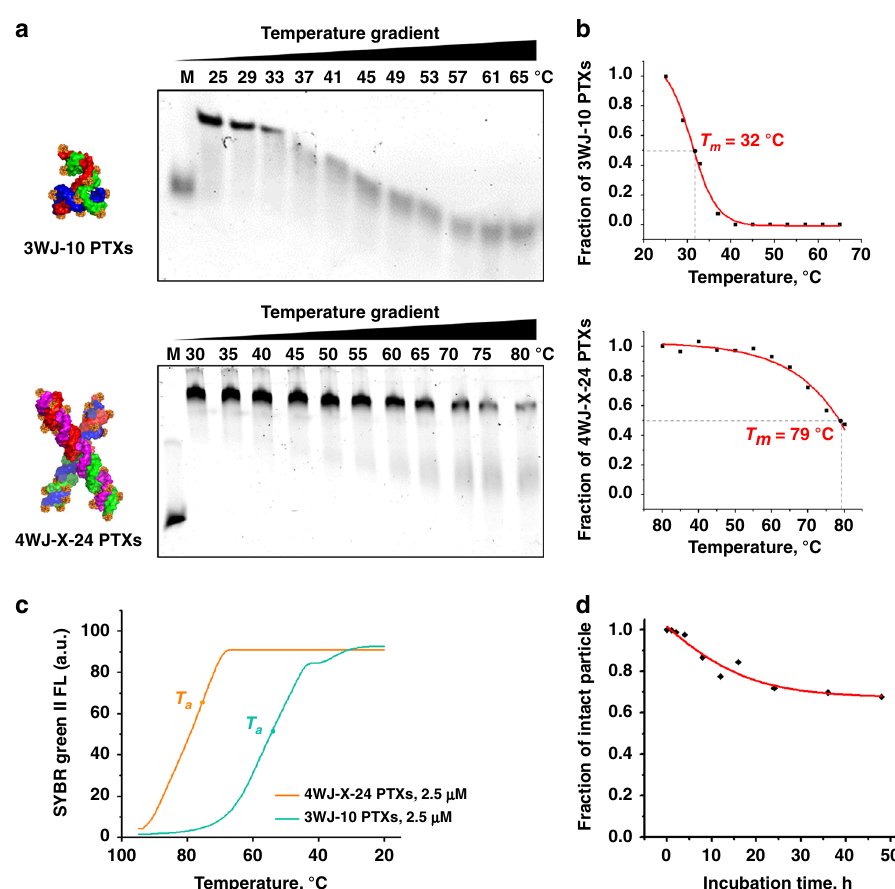
Fig. 4 Thermodynamic and chemical stability of 4WJ-X-24 PTXs nanoparticles. a Representative TGGE showing the T m of 3WJ-10 PTXs (M = 20 nucleotides monomer) and 4WJ-X-24 PTXs (M = 40 nucleotides monomer) nanoparticles. b Quantitative calculation of T m from the representative TGGE for 3WJ-10 PTXs and 4WJ-X-24 PTXs nanoparticles. c T a comparison of 4WJ-X-24 PTXs (orange) and 3WJ-10 PTXs (green) nanoparticles in a representative annealing curve, measured by RT-PCR ( n = 3 independent samples over three independent measurements). d Enzymatic stability curve of 4WJ-X nanoparticles after incubation in 50% FBS at 37 °C over time points. Source data are provided as a Source Data fi